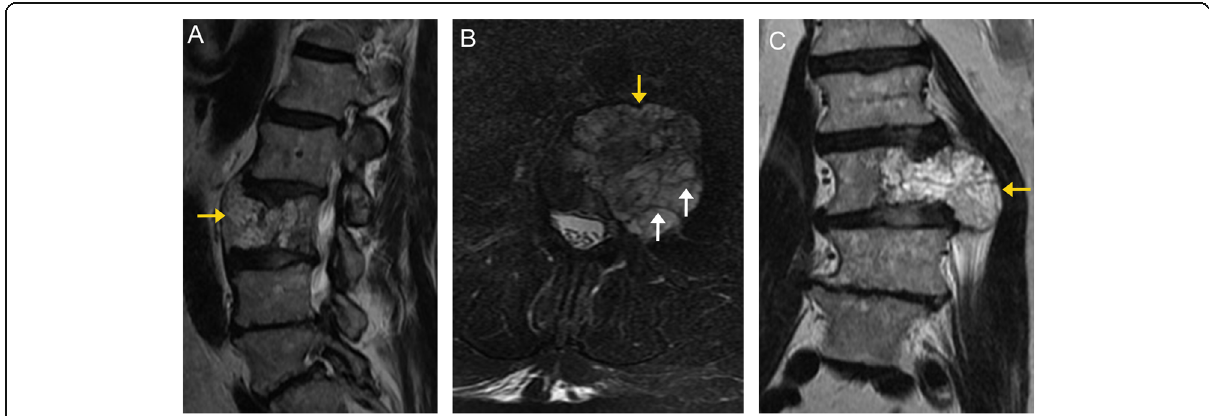
Fig. 17 Chordoma. Sagittal T2-weighted ( a ), axial T2-weighted fat-saturated ( b ), and coronal T2-weighted ( c ) images demonstrate a heterogeneously hyperintense, expansile and destructive lesion (orange arrows) involving the L3 vertebral body. Numerous internal septa (white arrows) are seen within the lesion, creating a “ honeycomb ” configuration. The lesion extrudes out and over the left aspect of the veretebral body (creating a "mushroom" appearance), and displaces the adjacent paraspinal